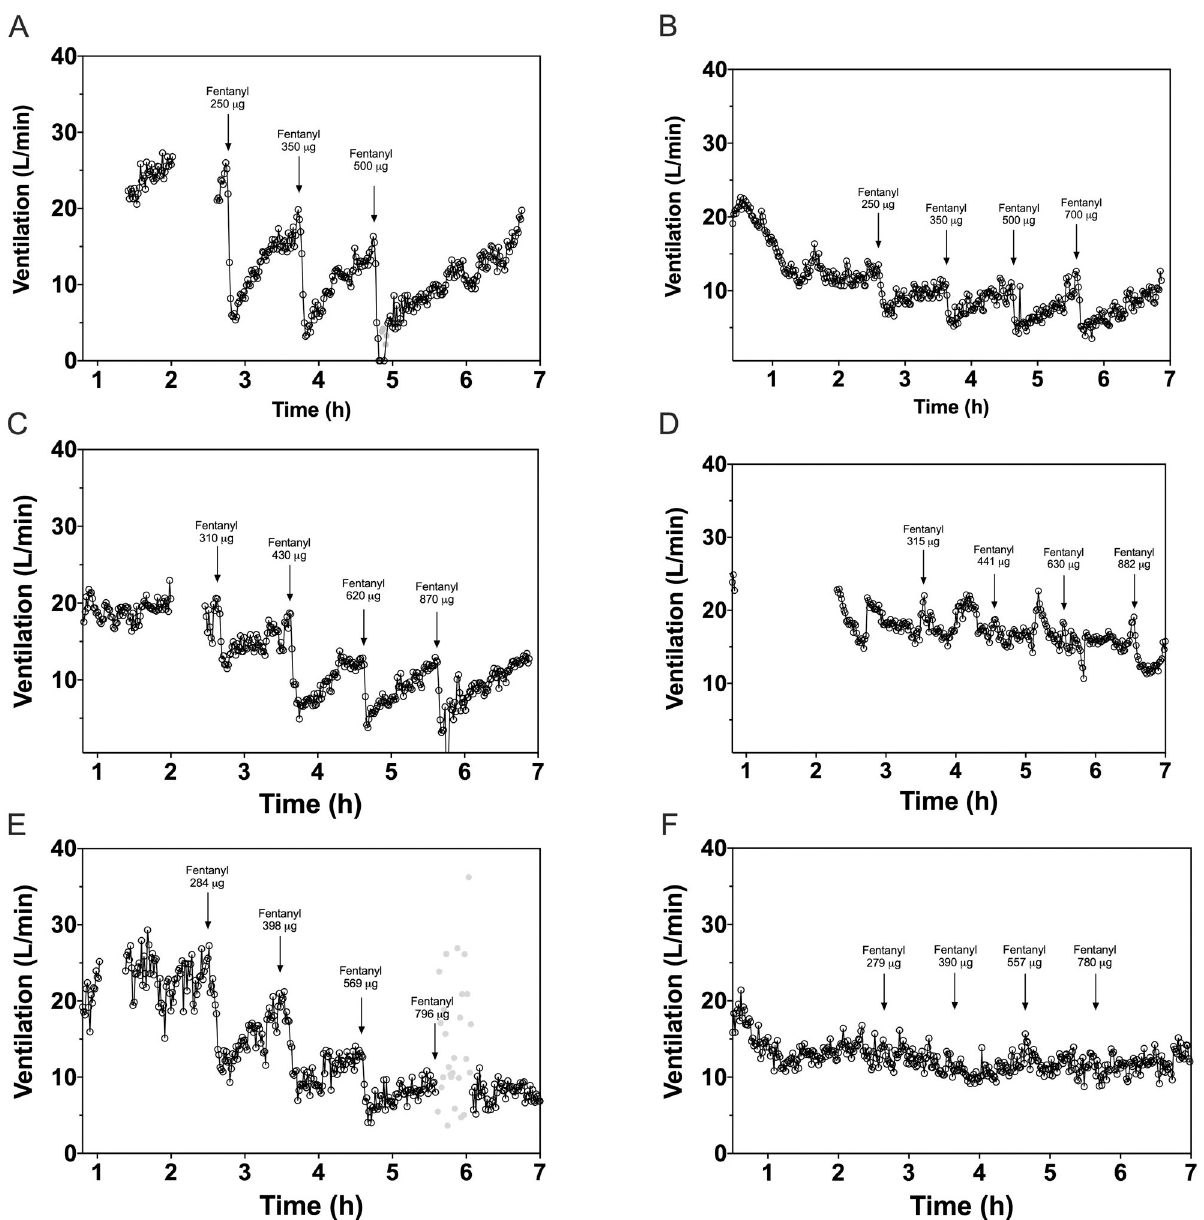
Fig 4. Example graphs showing the effect of fentanyl on minute ventilation in three opioid-tolerant patients during placebo infusion and buprenorphine infusion. (1) Placebo infusion (A, C and E) and buprenorphine infusion (B, D, F) at target plasma concentrations of 1 ng/mL (top row), 2 ng/mL (middle row) and 5 ng/mL (lower row). (2) Open spaces in the beginning of graphs A, C, D and E relate to concurrent clinical events such as temporary removal of the facemask. (3) Grey dots are stimulated breaths in case of an apnea episode. (4) The time on the x-axis in the graphs is related to the start time of the ventilation experiment, not the timing of the buprenorphine/placebo infusion and fentanyl injections.